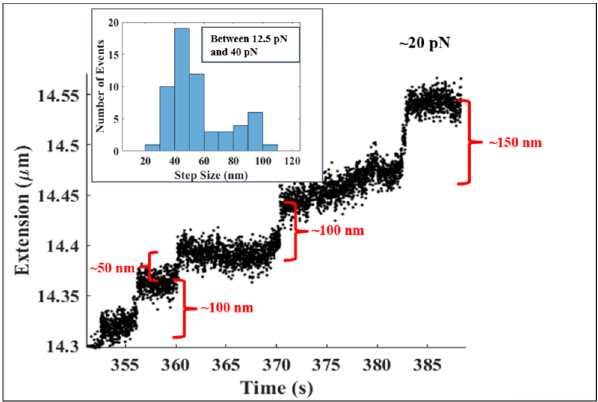
Figure 5. This figure shows the rupture of core histones from λ -DNA at a force of ~20 pN. The simultaneous release of core histones occurred in quantized step sizes of integral multiples of ~50 nm. Inset: Distribution of step sizes during the decompaction of the DNA tether from 10 s to 500